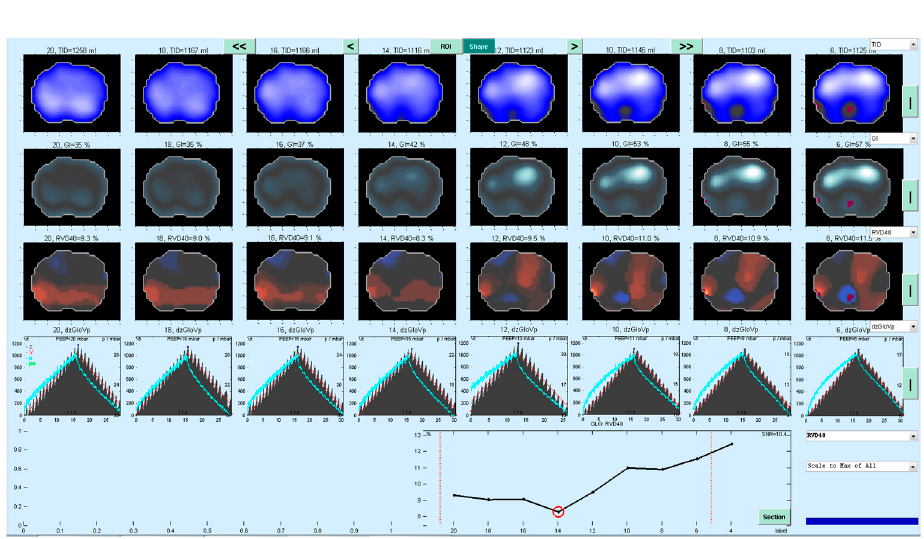
Figure 1. Example of a decremental PEEP trial and identification of PEEP IND using the RVD I method, illustrating the PEEP steps 20–6 cm H 2 O. Distribution of tidal ventilation significantly shifts to nondependent (ventral) lung areas with decreasing PEEP levels (top row). RVD I reaches its minimum at a PEEP level of 14 cm H 2 O (third row of images from top, line graph at the bottom). Likewise, Global Inhomogeneity Index (second row of images from top significantly increases below PEEP levels of 14 cm H 2 O. Maximum dynamic compliance was reached at a PEEP level of 16 cm H 2 O and was 152 mL/cm H 2